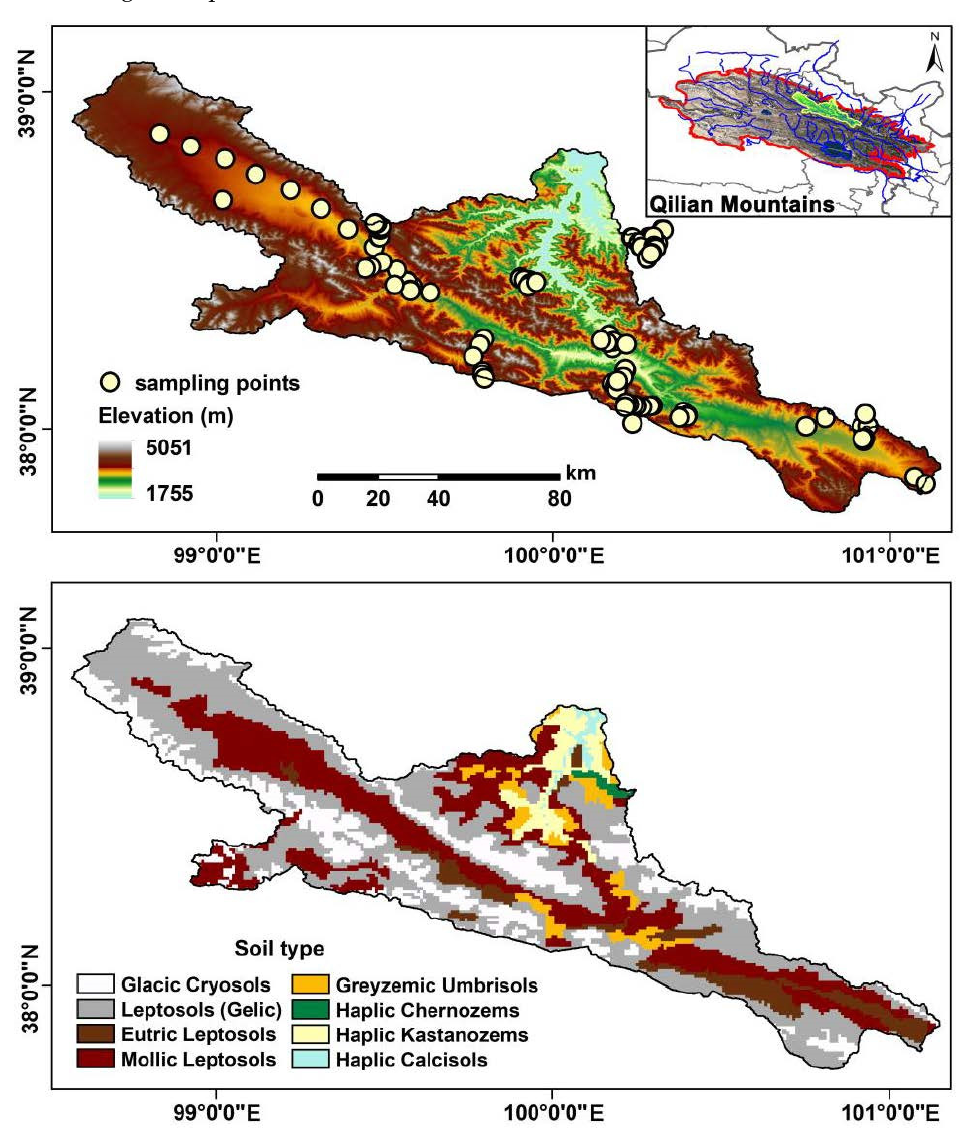
Figure 1. Distribution of sampling points and soil types across the Yingluoxia basin in the middle Qilian Mountains.